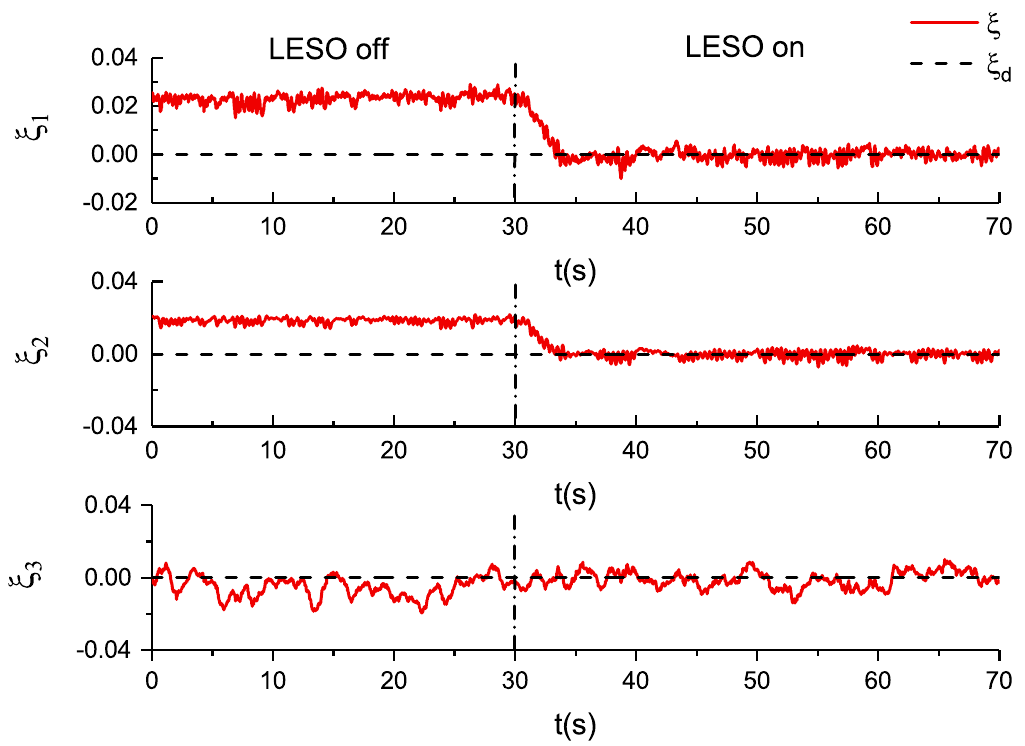
Figure 5. Attitude-stabilization effect with the LESO off and on.